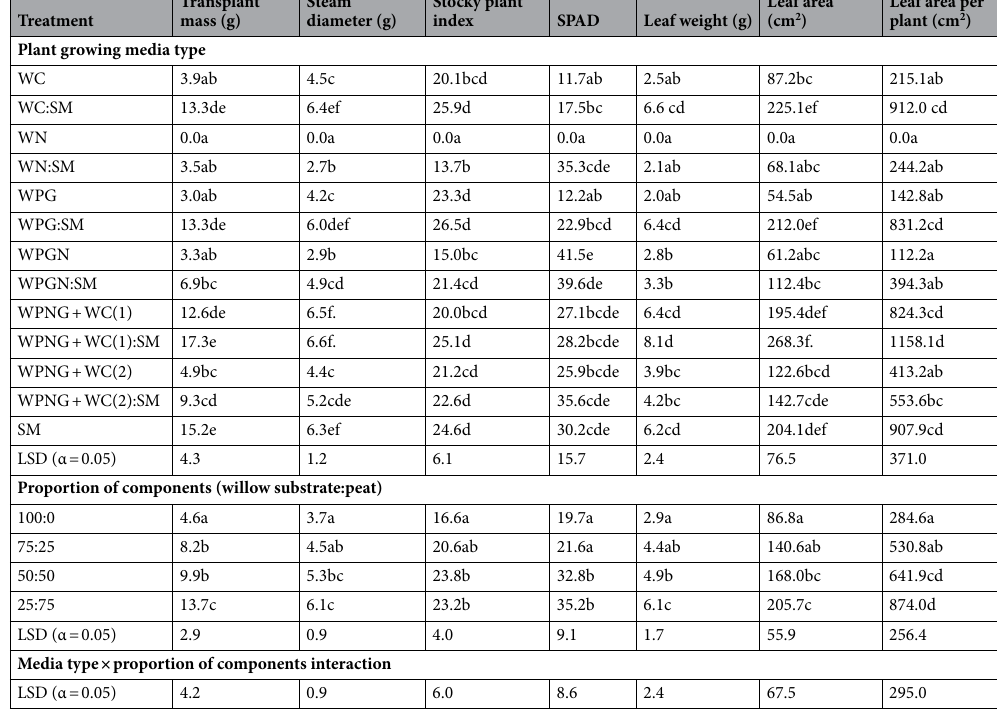
Table 6. The effect of horticulture media and components proportion on cucumber transplant parameters.